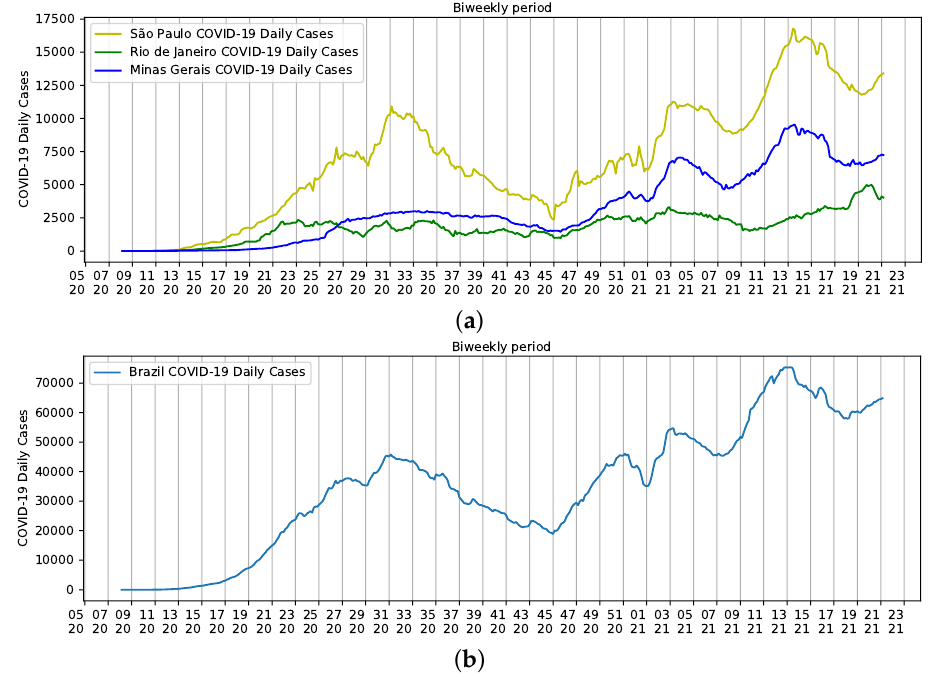
Figure 3. Biweekly cases of COVID-19 reported from epidemiological week five of 2020 to epidemio- logical week 22 of 2021. ( a ) States of São Paulo (yellow), Rio de Janeiro (Green), and Minas Gerais (Blue); ( b ) Brazil.